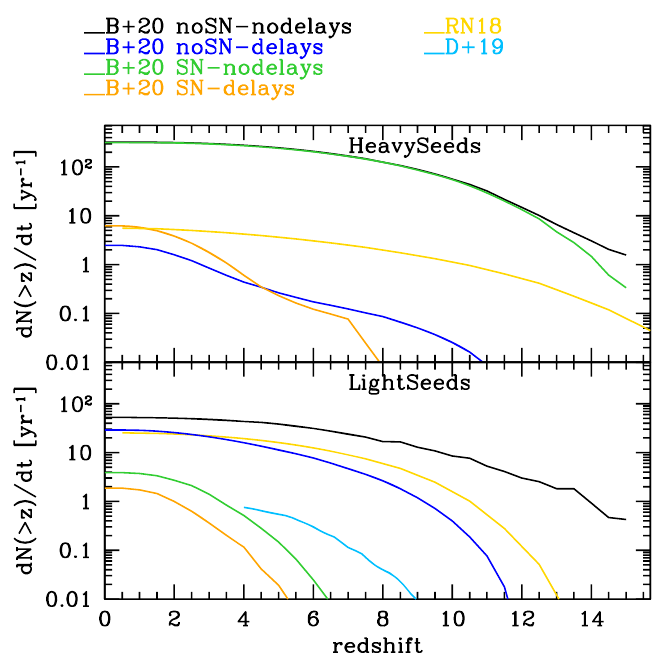
Fig. 25 Comparison of merger rates from different semi-analytical models, assuming heavy seeds (top panel) and light seeds (bottom panel). For all models, we employed the Science Requirement curve (Babak et al. 2021) applying an SNR cut of 8. Different assumptions for models by Barausse et al. (2020b) are shown, with or without SN feedback, and including or not delays. Dayal et al. (2019) include reionisation feedback and delays, whereas Ricarte and Natarajan (2018b) do not include delays. The still large uncertainties in the modelling result in signi fi cant variations, up to two orders of magnitude, with mergers between light seeds typically dominating the event rate, but for the case when SN feedback is included, as in Barausse et al. (2020b). Image credit: Marta